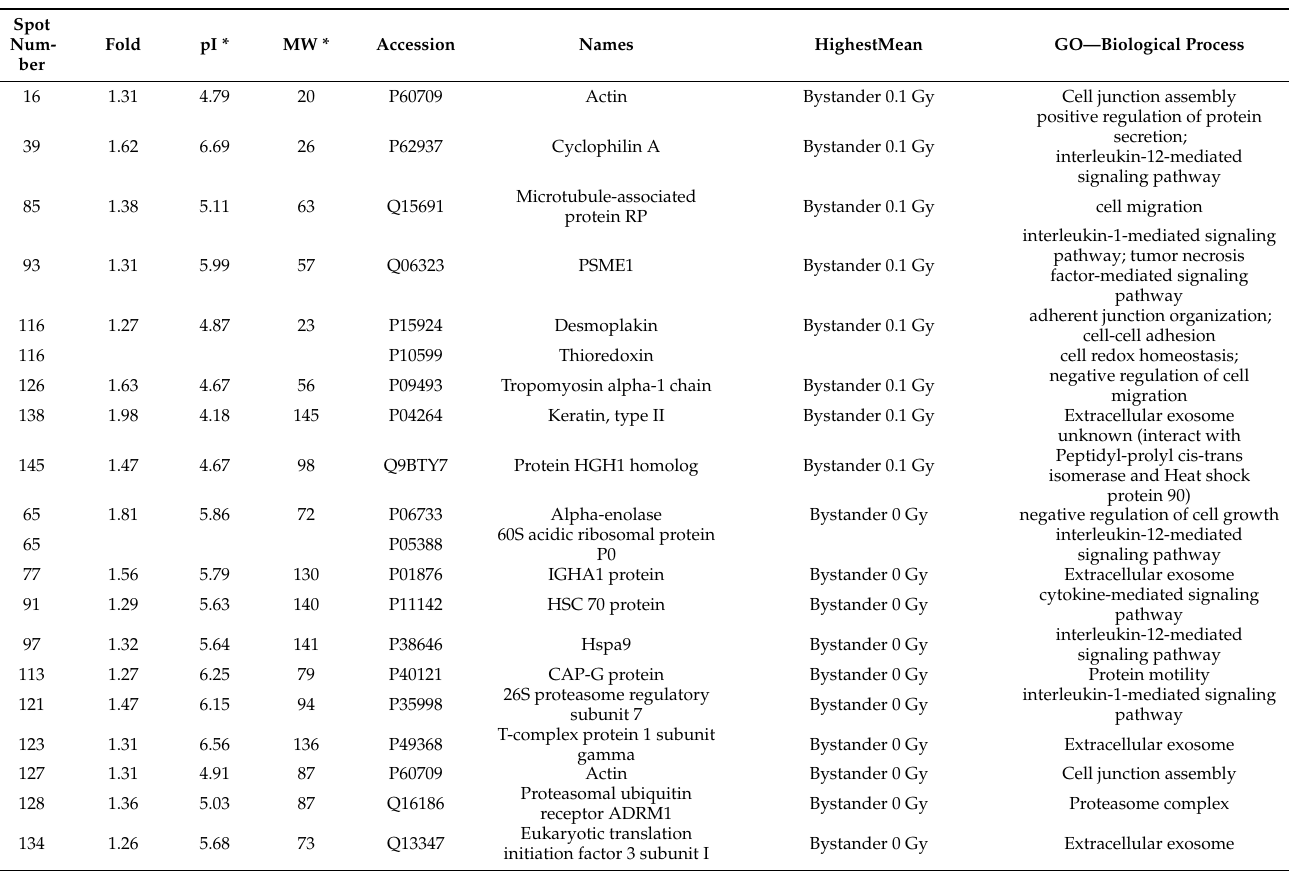
Table 2. List of 20 modulated proteins in the proteome of bystander cells receiving the conditioned medium of low-dose irradiated chondrosarcoma cells, as compared with bystander cells receiving the conditioned medium non-irradiated chondrosarcoma cells.